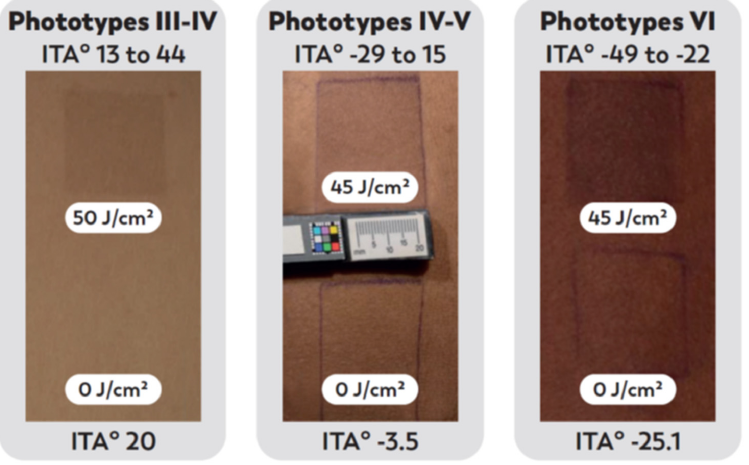
Figure 5. Hyperpigmentation induced by UVA1 exposure in vivo. Examples of UVA1-induced hyperpigmentation (PPD) 1.5–2 h after exposure to UVA1 in individuals with different skin color types, up to heavily pigmented skins. Inclusion criteria for Fitzpatrick phototypes and ITA° values (skin color type according to [193]) for the volunteers included in clinical studies are indicated at the top of one representative photograph. The specific ITA° values of the illustrated subjects are indicated at the bottom of the corresponding photograph. UVA1-induced darkening of the skin contributes to no photoprotection while induc- ing DNA and cellular damages [184]. Moreover, pigmented skins up to phototype VI, usually considered to be well protected against UV-induced damage, also show that UVA1-induced hyperpigmentation is associated with changes in the expression of genes